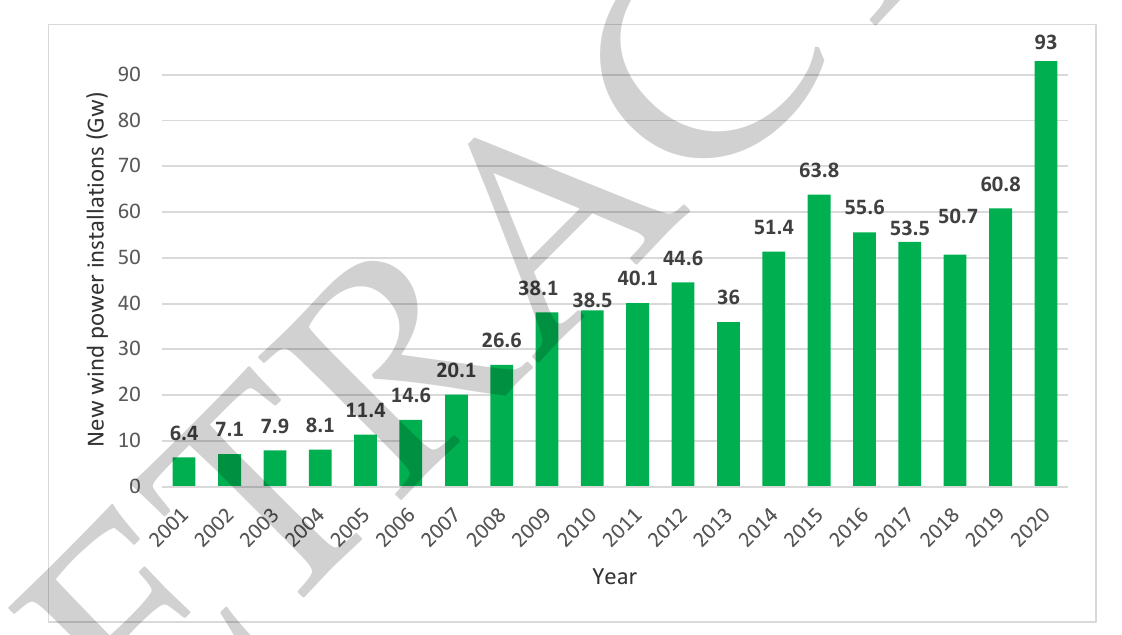
Figure 1. Added wind capacity in the globe each year for 2001–2020 [8].